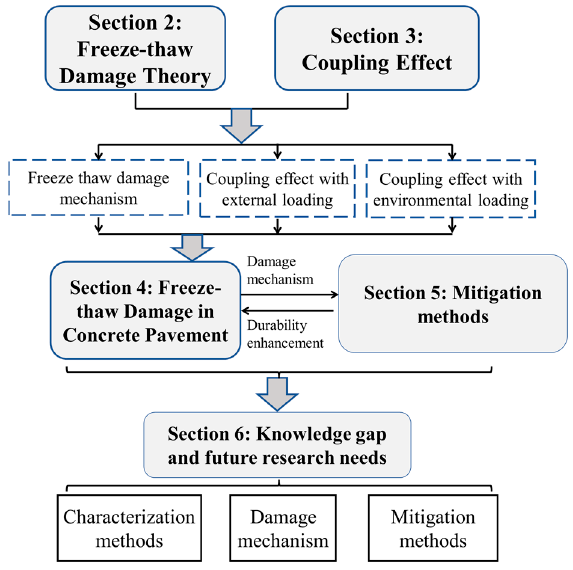
Figure 2. Scheme of the review article. Table 1. Summary on the references related to freeze–thaw damage in concrete pavement.